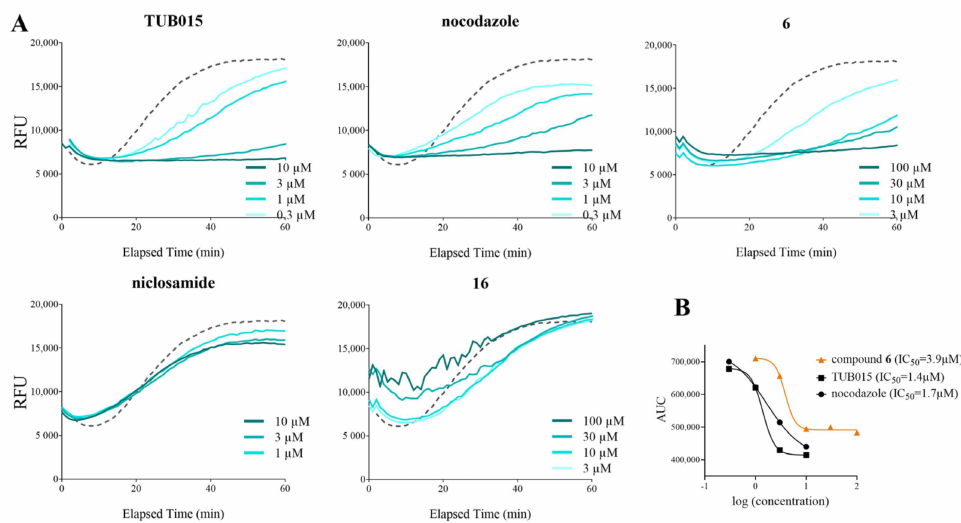
Figure 3. Compound 6 inhibits the rate and extent of tubulin polymerization in vitro. ( A ) Dose dependent effect on in vitro tubulin polymerization in the presence of vehicle (DMSO, dashed line) or a range of concentrations of TUB015 ( 4 ), nocodazole ( 5 ), compound 6 , (upper panel), or niclosamide ( 7 ) and compound 16 (lower panel). All conditions were tested in duplicate, and graphs represent average values of two ( n = 2) independent experiments. ( B ) The measured IC 50 values